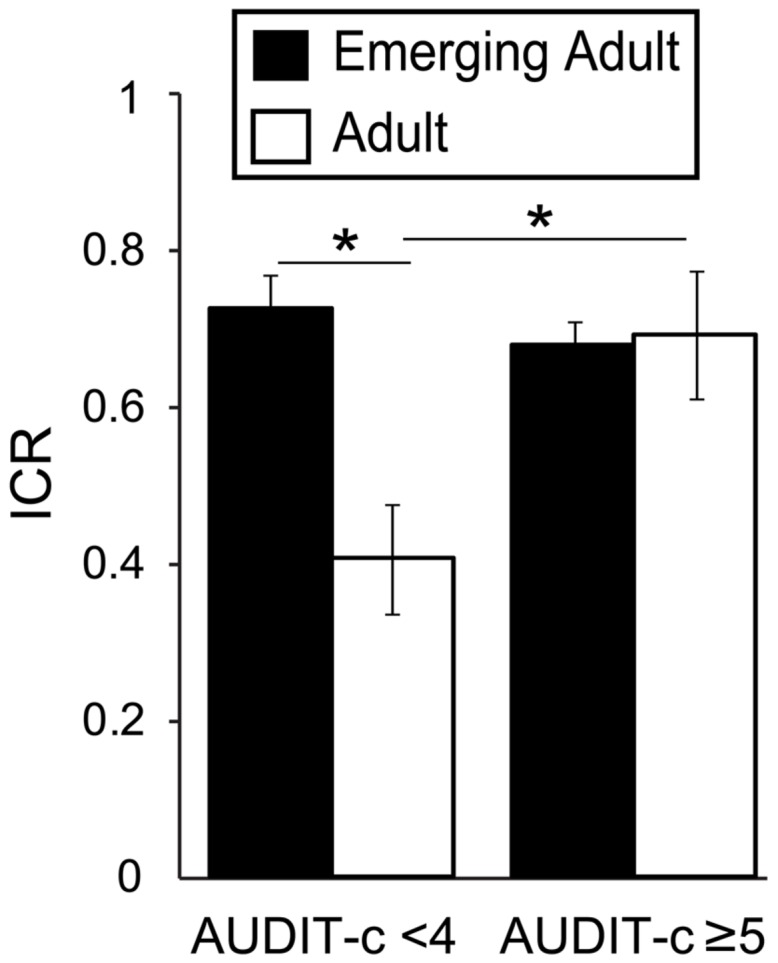
Interacting effects of age and AUDIT-c scores on Now bias. Plot depicts the ratio of immediate reward choices (ICR) in the delay-discounting task as a function of AUDIT-c (high/low) and age (adult/emerging adult) groups. There were significantly interacting effects of age and AUDIT-c on ICR, [F(1,157) = 8.32, p = 0.004, η2 = 0.047]. This result reflects significantly higher average ICR in the high AUDIT-c versus low AUDIT-c adults [t(27) = -2.28, p = 0.031, d = -0.88], but no difference between AUDIT-c groups among emerging adults [t(115.216) = 1.018, p = 0.311, d = 0.17]. low AUDIT-c: <4; high AUDIT-c: ≥5; AUDIT-c, AUDIT consumption subscale. ∗p < 0.05.